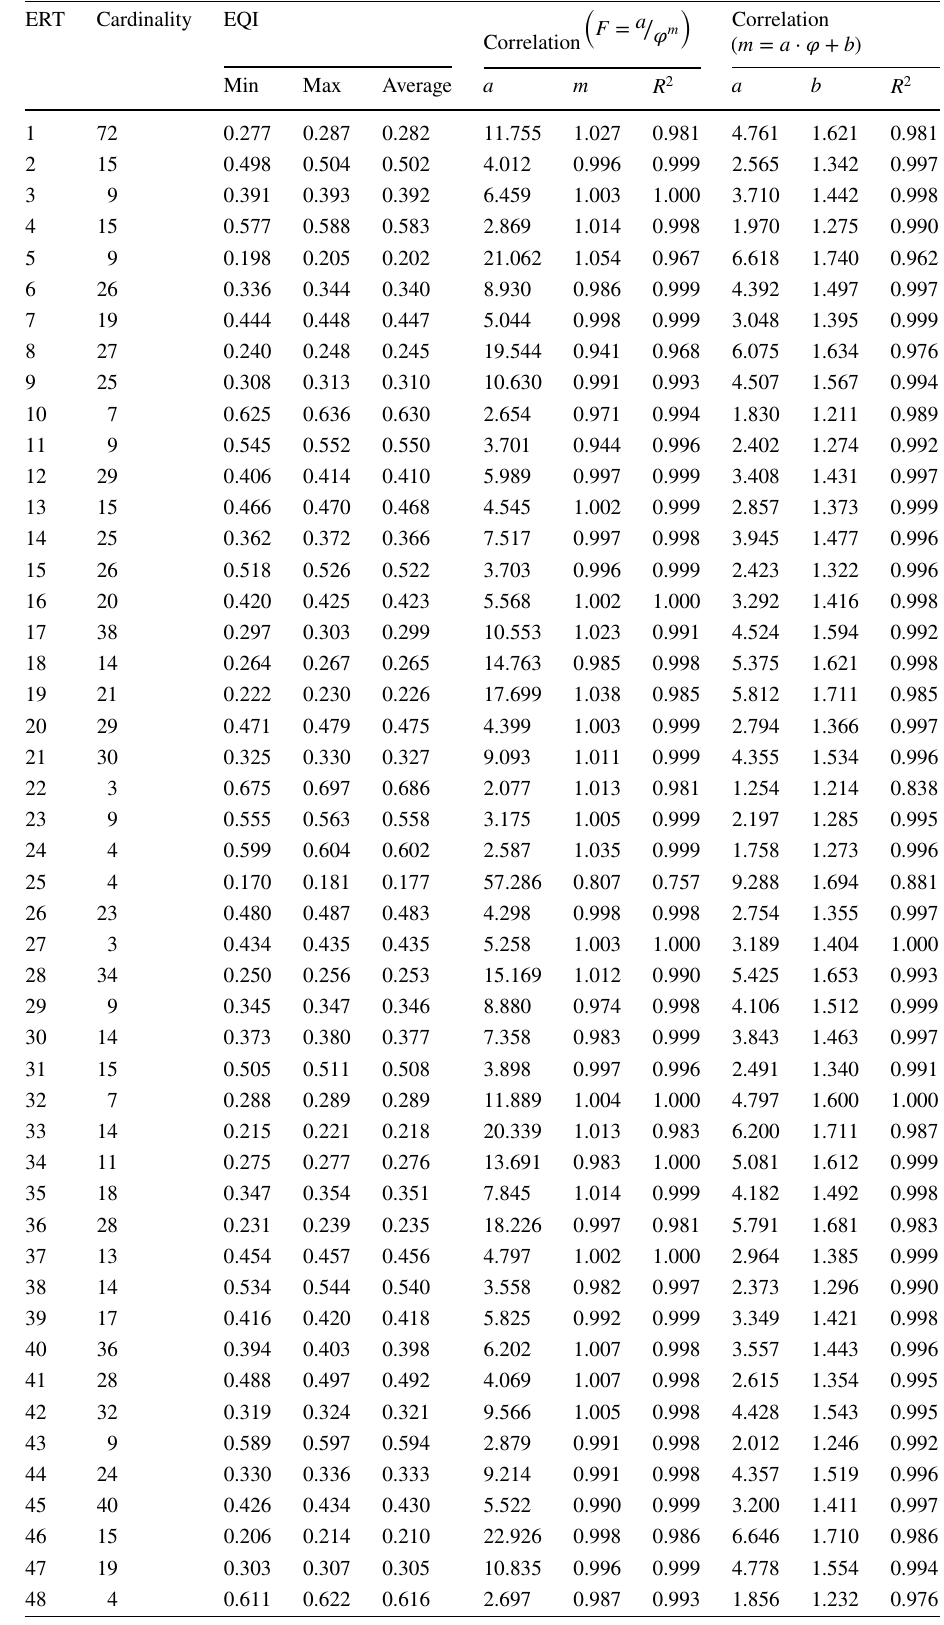
Table 6 Results of EQI technique for 65 ERTs generated by EQI-GMM model on training data from sandstone